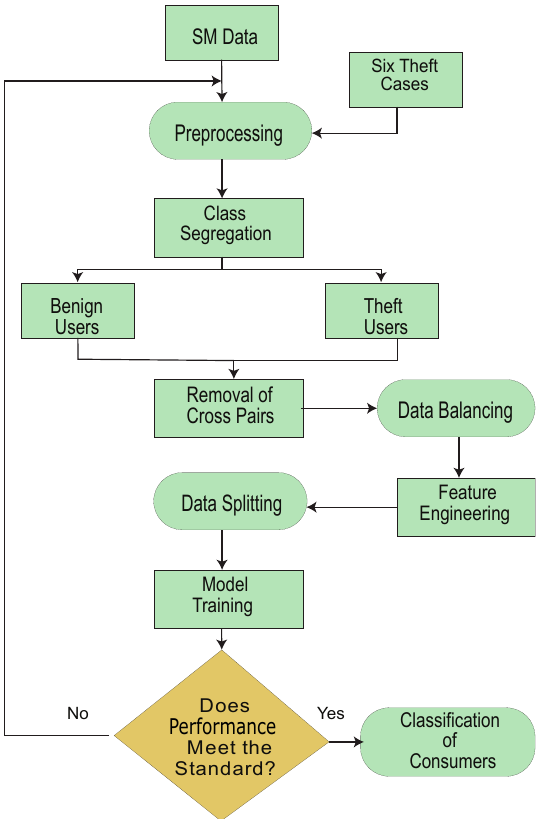
Figure 5. Methodology outline for detection of